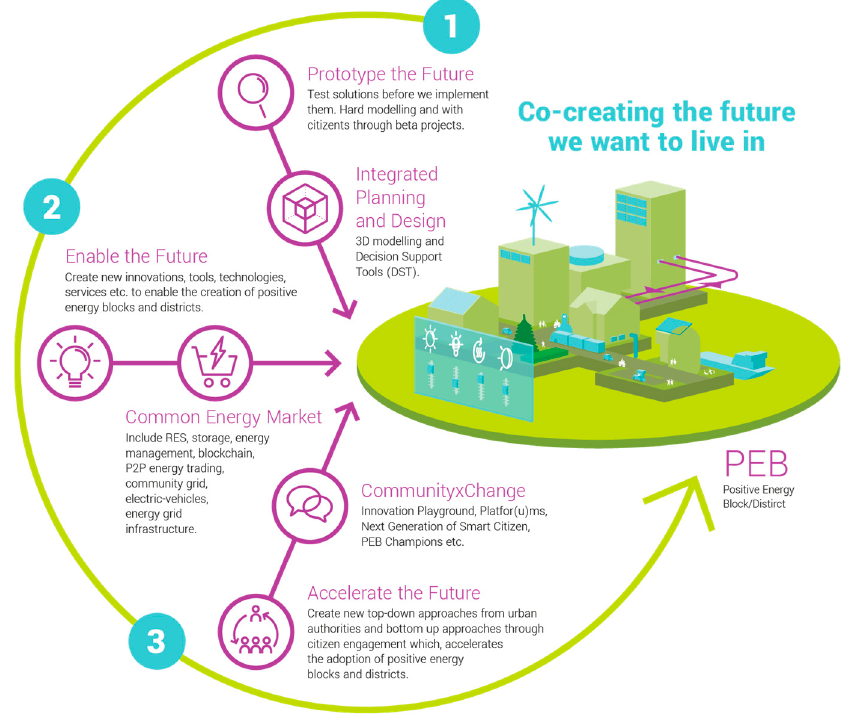
Figure 2. The +CityxChange project vision infographic (Source: [23] )